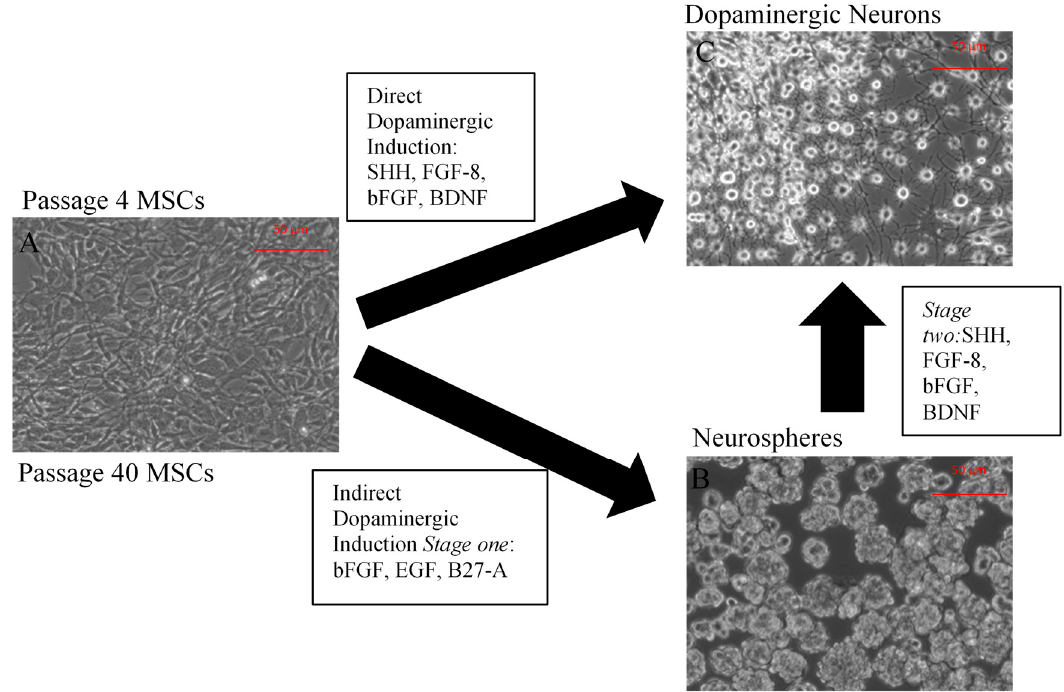
Figure 1. Overview of the direct dopaminergic induction (DDI) and indirect dopaminergic induction (IDI). Undifferentiated P4 or P40 BM-MSCs ( A ). Neurosphere formation following Stage One of the IDI ( B ). Dopaminergic neurons following the DDI or Stage Two of the IDI ( C ).